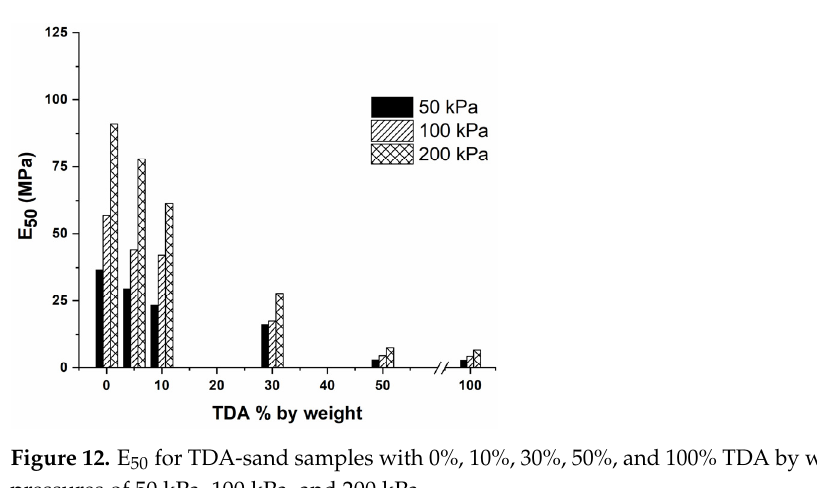
Figure 11. E 50 for TDA-gravel samples with 0%, 10%, 20%, 30%, and 100% TDA by weight at confining pressures of 50 kPa, 100 kPa, and 200 kPa.